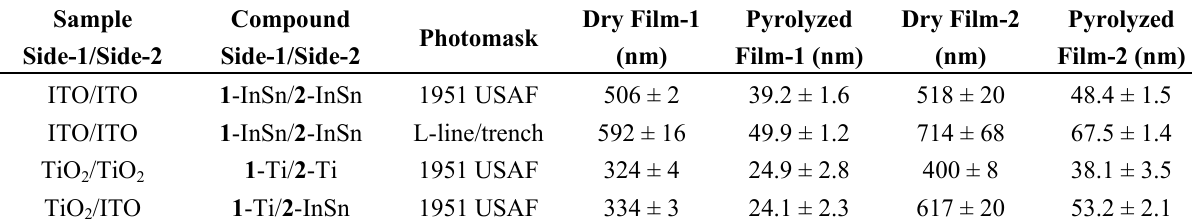
Table 2. Dual-sided films.